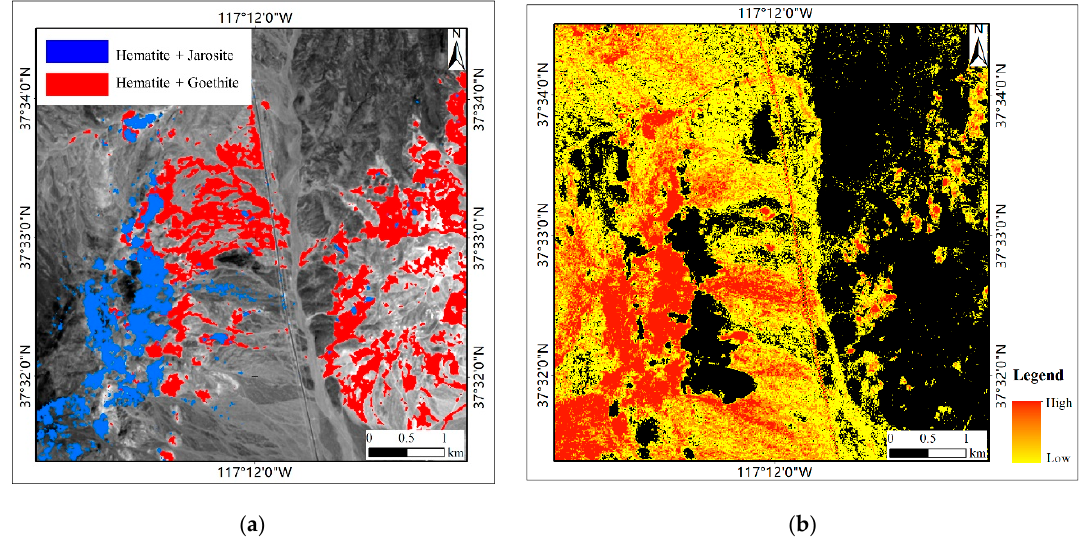
Figure 5. Distribution of iron minerals in the Cuprite area. ( a ) Shows the iron minerals distribution obtained from the fused Sentinel-2 data; ( b ) shows the mixture of iron-bearing minerals extracted from the fused Sentinel-2 data.